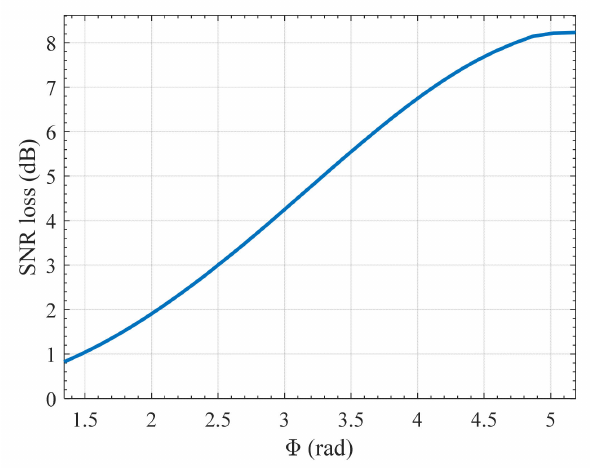
Figure 8. Dependence of the SNR loss on the phase